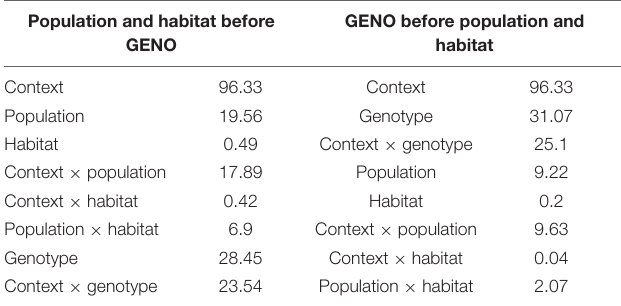
TABLE 4 | Anova (type I) models of amount (%) of variation in methylation explained by population, habitat, and sequence context before (left) and after (right) accounting for genotype effects on methylation using MAF-filtered data only (8,960 contigs).